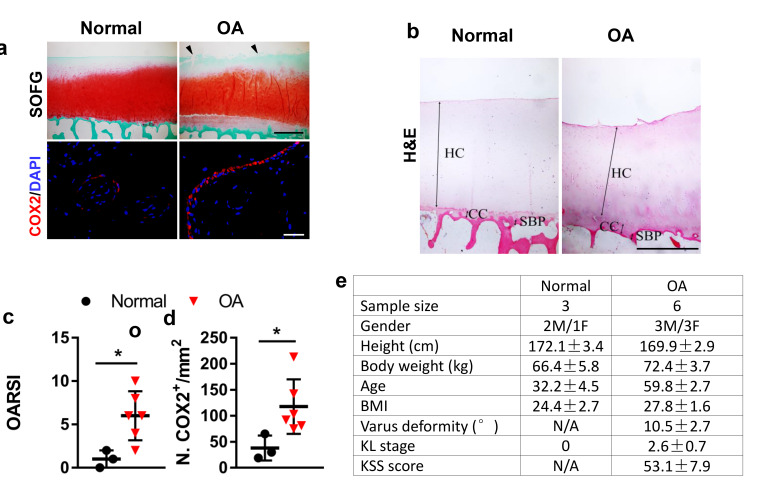
Parameters of aberrant subchondral bone remodeling in human and mice osteoarthritis.(a, b) Representative photographs (a) and statistical analysis (b) of TRAP staining in mice 1 month and 2 month after ACLT of sham surgery. scale bar, 50 μm, n = 6 per group. (c, d) μCT 3D analysis data: TV (c) and Tb. Pf (d) of mice knee subchondral bone 4 w after ACLT or sham surgery, n = 6 per group. (e, f) H and E staining of cartilage and subchondral bone of mice ACLT or sham surgery (e) and human OA or healthy samples (f). scale bar, 50 μm (e), 200 μm (f). (g) Demographic data of human patients. *p<0.01, ***p<0.001, ****p<0.0001 compared with the sham-operated group or healthy donors at different time points. Statistical significance was determined by unpaired Student’s t test (b, c and d), and all data are shown as scattered plots with means ± standard deviations.